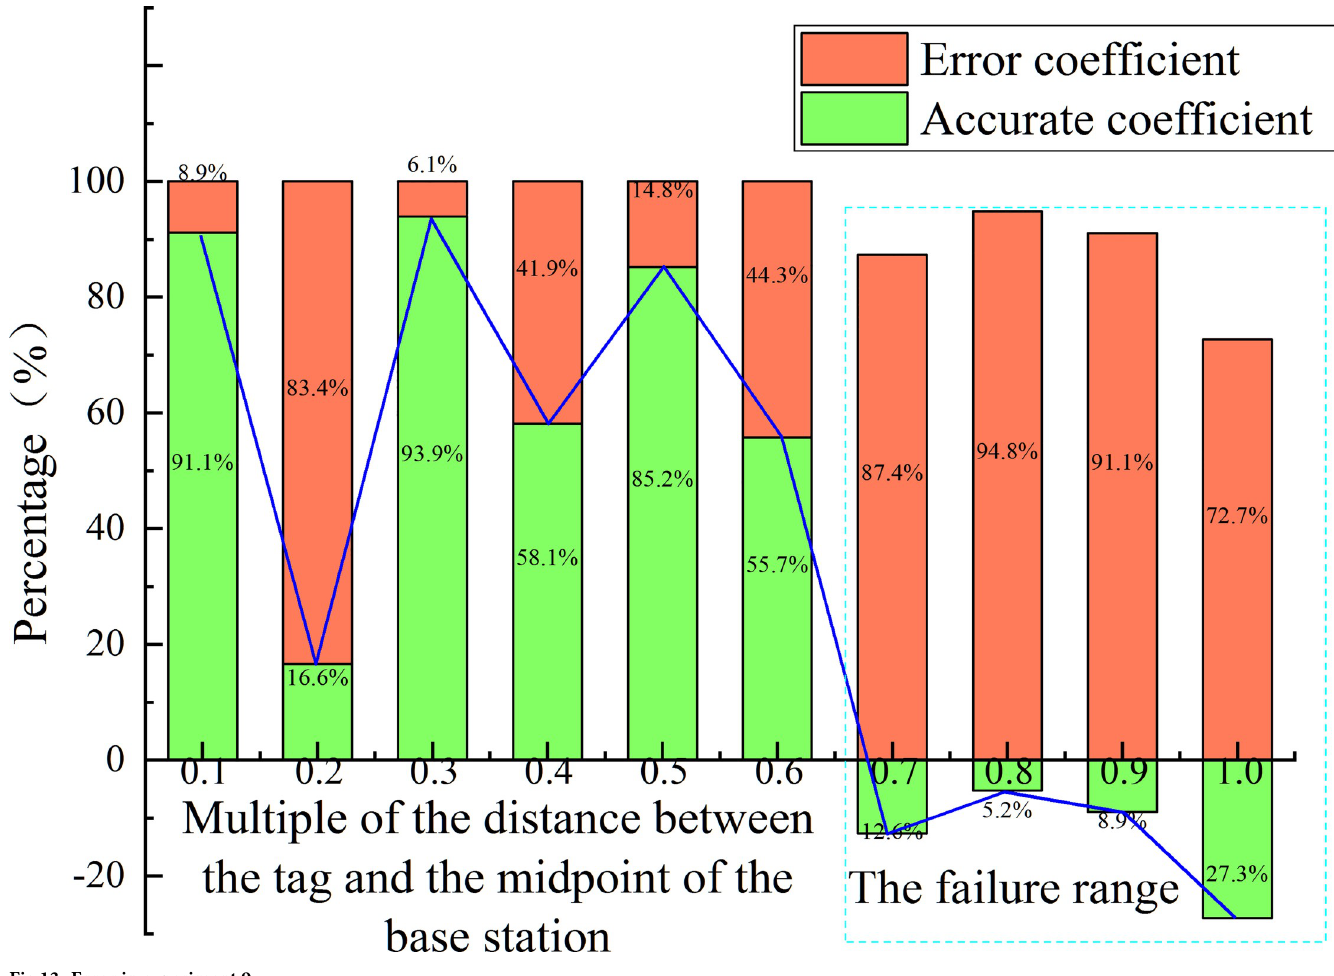
Fig 13. Error in experiment 9.